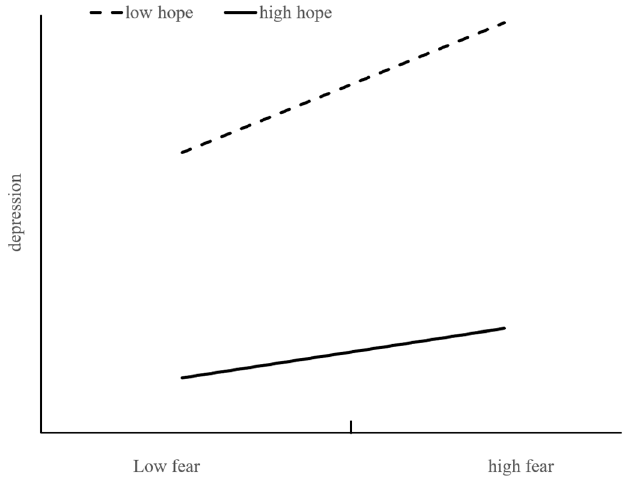
Figure 2. Hope as a moderator between fear of COVID-19 and depression.